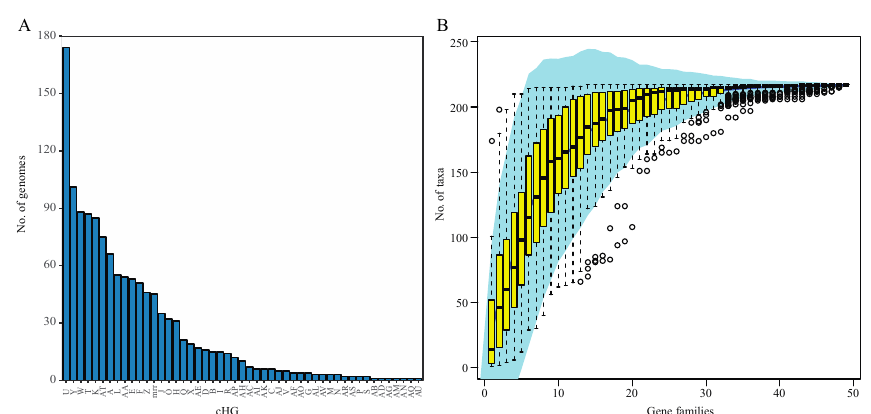
Figure 1. Distribution of collapsed Homologous Group (cHG) among haloarchaeal genomes. ( A ) The number of genomes present in each collapsed Homologous Group (cHG). No cHG contains a representative from every genome used in this study. With the exception of one cHG, all contain members from fewer than half of the genomes. The cHGs are ordered by number of genomes they contain. ( B ) Rarefaction plot of the number of genomes represented as cHGs accumulate. A 95% confidence interval is shown in shaded blue area and the yellow box whisker plots give the number of taxa from random subsamples (permutations = 100) over 48 gene families.